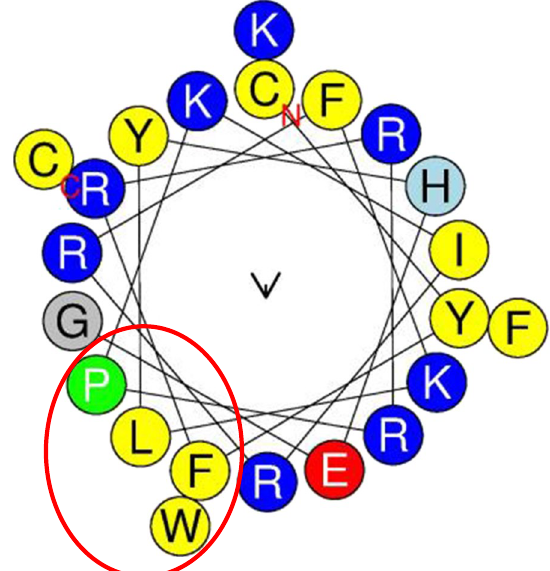
Fig. 3 Helical wheel diagram of Pp -ALF LPS domain predicted by HeliQuest. The amino and carboxy ends are denoted as N and C, respectively. The predicted hydrophobic face (-FWLP-) was marked with a